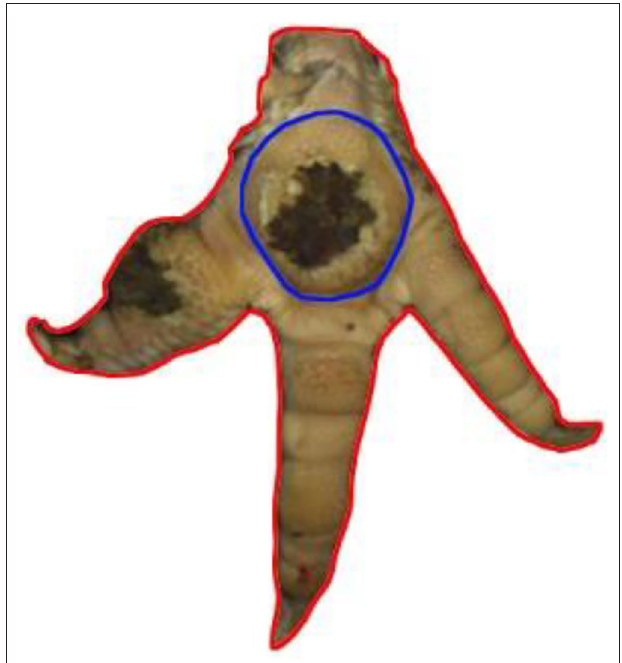
FIGURE 1 | References for scoring. Total foot = RA1 is marked in red; Metatarsal pad = RA2 is marked in